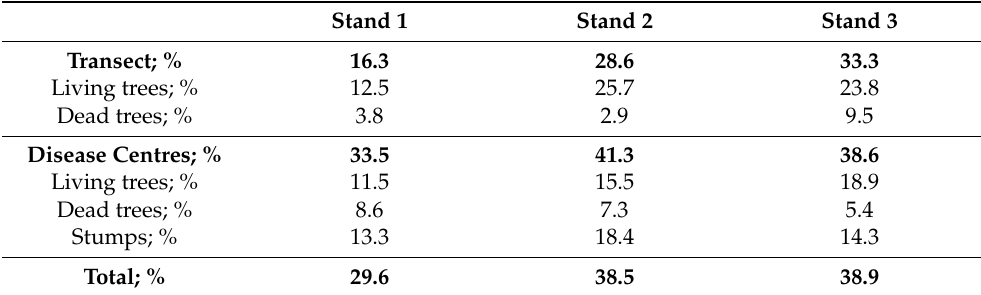
Table 3. Frequency (% *) of Norway spruce trees or stumps infected by Heterobasidion parviporum in managed forests on former pastures and meadows.